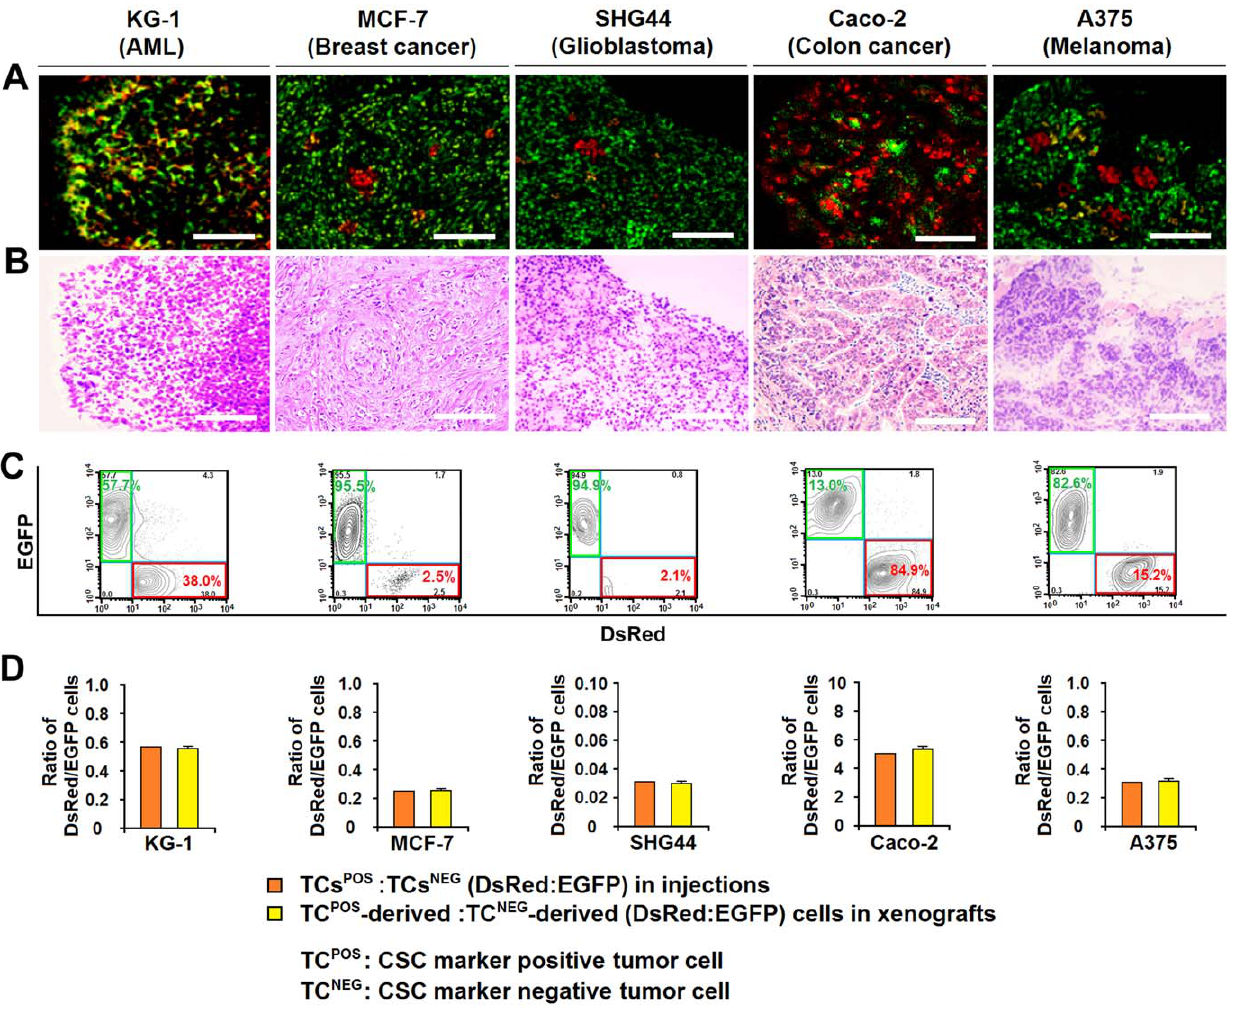
Figure 3. CSC + and CSC 2 tumor cells display similar tumor-forming capacity upon co-transplantation. ( A and B ) DsRed-labeled CSC + and EGFP-labeled CSC 2 cells originating from the same tumor cell lines were mixed to their original ratio and co-transplanted into sublethally irradiated NOD-SCID mice. Photographs represent fluorescent images ( A ) and hematoxylin and eosin staining ( B ) of serial sections of the xenografts derived from KG-1, MCF-7, SHG44, Caco-2 and A375. Scale bar =100 m m. ( C ) Flow cytometric contour plots show the percentage of DsRed and EGFP cells in the xenografts. ( D ) Histograms show the ratio of CSC + to CSC 2 (DsRed:EGFP) cells in injections and the ratio of CSC + -derived to CSC 2 -derived (DsRed:EGFP) cells in xenografts. Data represent mean 6 SEM from 3 independent